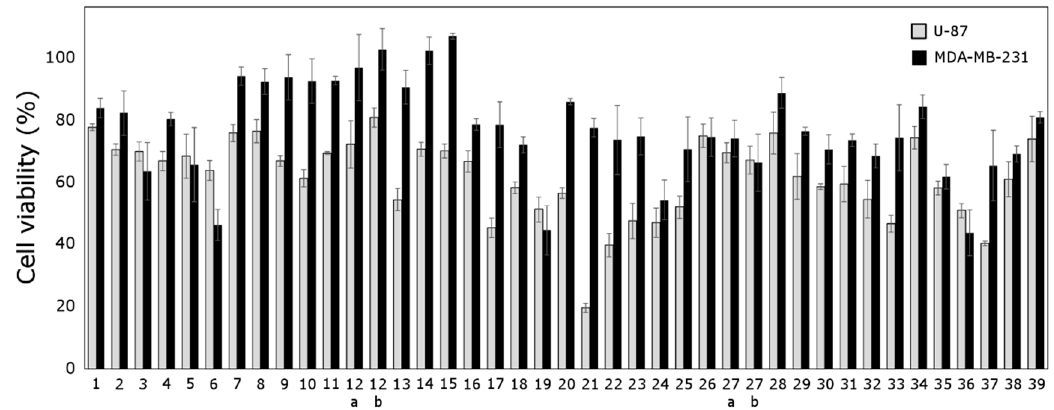
Figure 1. Cell viability reducing activity of the synthesized compounds 1 – 39.